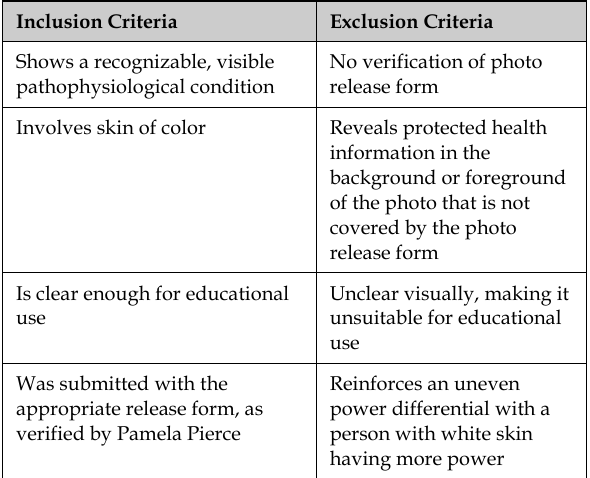
Table 1 Inclusion and exclusion criteria for